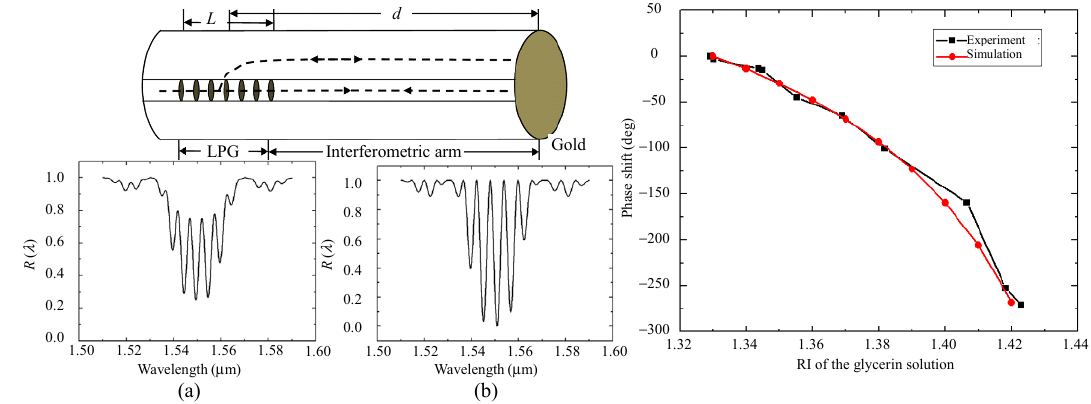
Fig. 24 Schematic diagrams of MI without splicing based on an LPFG and its spectra and RI response [169].